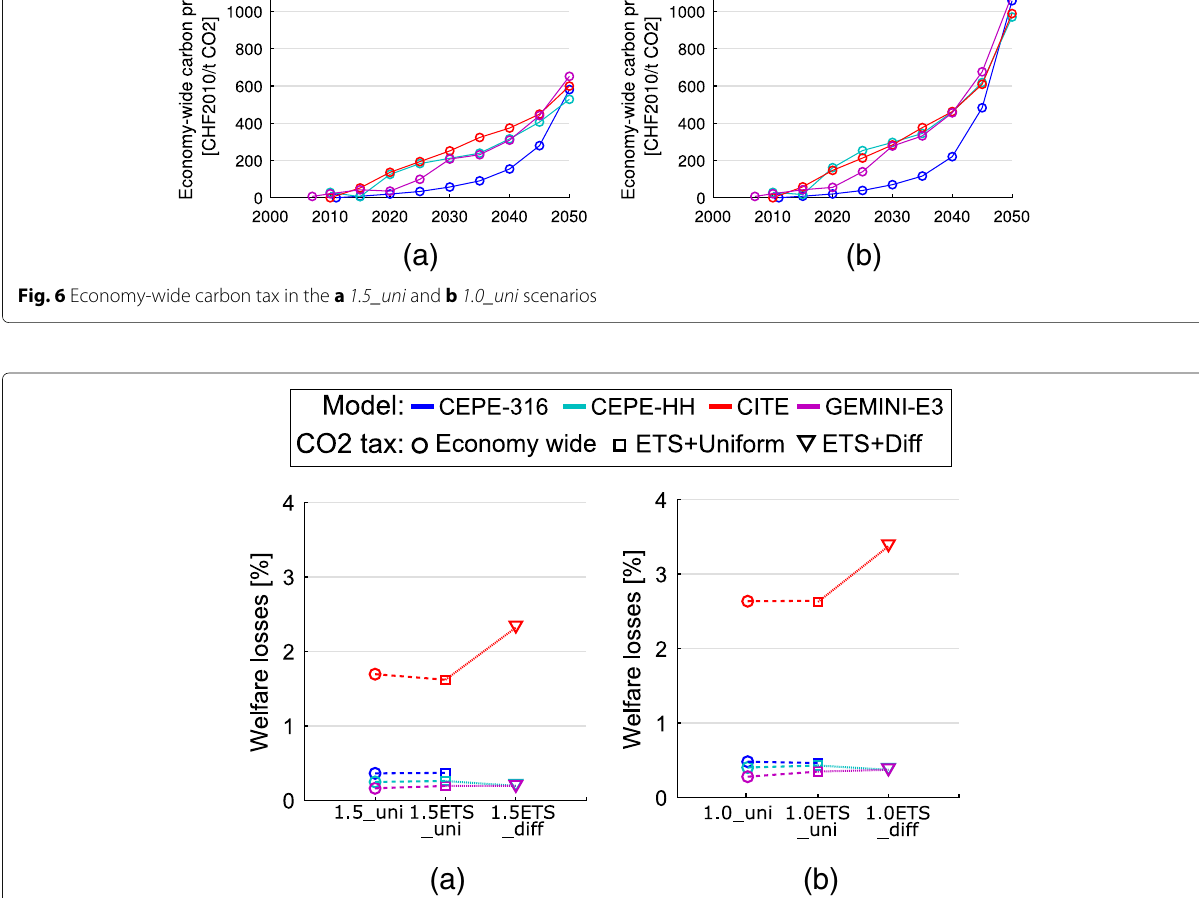
Fig. 7 Cumulative welfare losses. a 1.5 tpc per target. b 1.0 tpc per